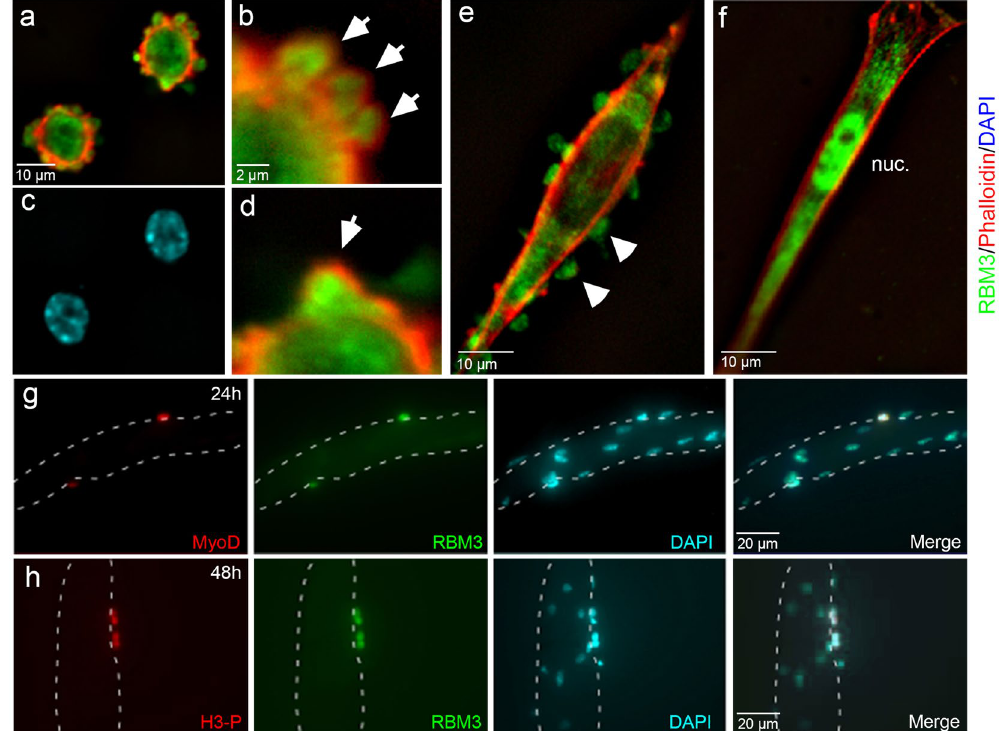
Figure 5. Dynamic localization of RBM3 in differentiating primary myoblasts. ( a ) Image of F-actin (red, phalloidin), RBM3 (green) in myoblasts fixed shortly after plating (1 hr) onto fibronectin. SICs are clearly visible along the edges of recently adherent cells as F-actin-delimited outpouchings of membrane. RBM3 is concentrated within SICs. ( c ) DAPI-stained nuclei in cells from Panel a. ( b and d ) Blowup of upper and lower margins of cell from the top-right portion of panel A. SICs (arrowheads) can be seen clearly with a peripheral F-actin ring surrounding an RBM3-rich core. ( e ) Image of a myoblasts partially differentiated into a myotube. At this stage, RBM3 is present in membranous blebs devoid of F-actin that are known to mediate myoblast migration. ( f ) Image of a fully differentiated satellite cell. RBM3 relocalizes from membrane protrusions to the cytoplasm and nucleus (nuc). ( g ) Images of a myotube explant at 24 hrs in culture in which activated satellite cells migrating along the myotube border (dashed outline) co-express MyoD (red) and RBM3 (green). ( h ) Images of dividing satellite cells along the border of a myotube that co-label for histone H3 phosphate (H3-P, red) and RBM3